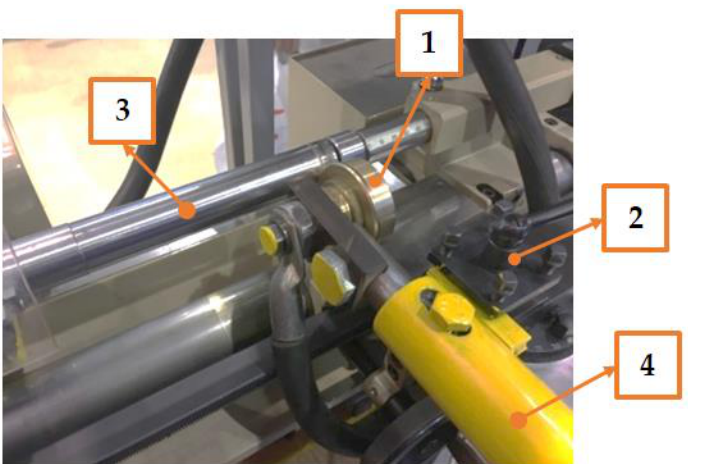
Figure 1. The Start bench lathe trial plant: 1—roller electrode, 2—power supply system, 3—sample, 4—tool holder.